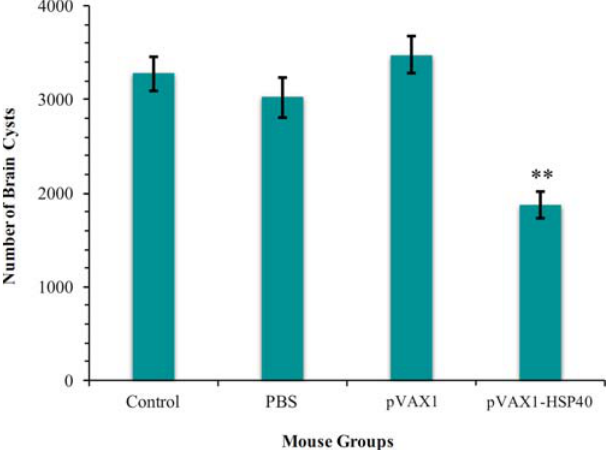
Figure 4. pVAX1-HSP40-based immunization protected against chronic infection. Number of brain cysts in mice challenged orally with 10 Pru cysts two weeks post the final immunization. The brain cysts in the pVAX1-HSP40-immunized mice were significantly lower compared with those in the control mouse groups (** p < 0.01). No significant difference was detected between the control mouse groups ( p >